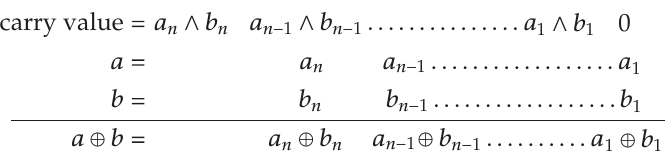
Figure 1: Carry generated in i th column counted from LSB is saved in (cid:2) i (cid:7) 1 (cid:3) th column.